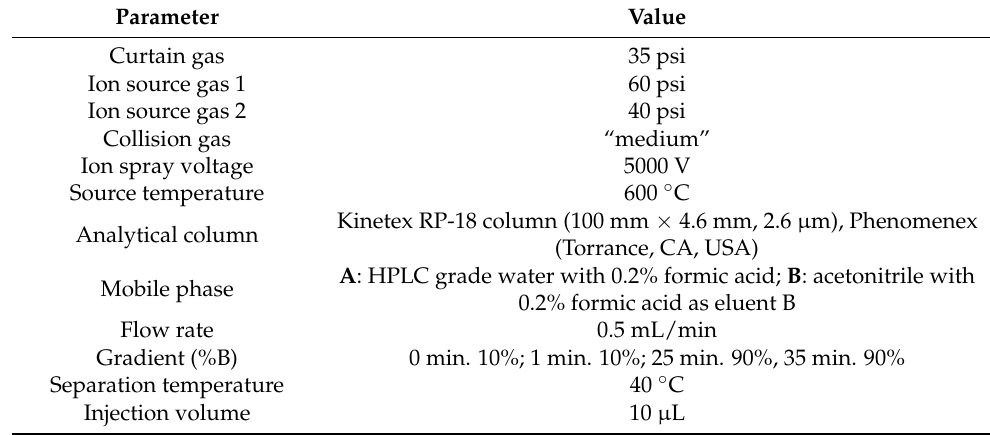
Table 6. Instrumental conditions of